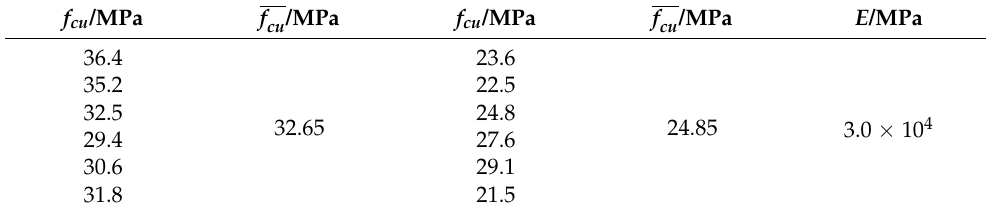
Table 3. Mechanical properties of reinforcing steel materials.